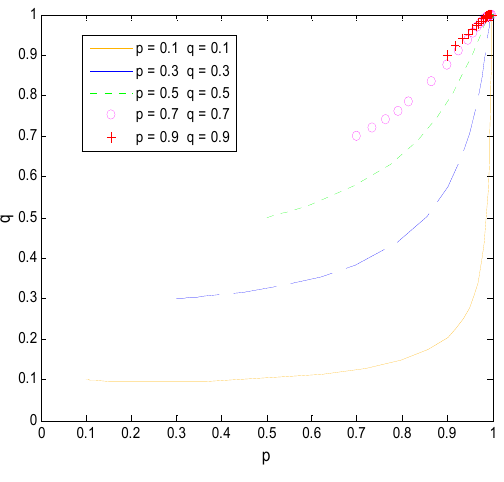
Figure 8. The evolution process of Case 3.